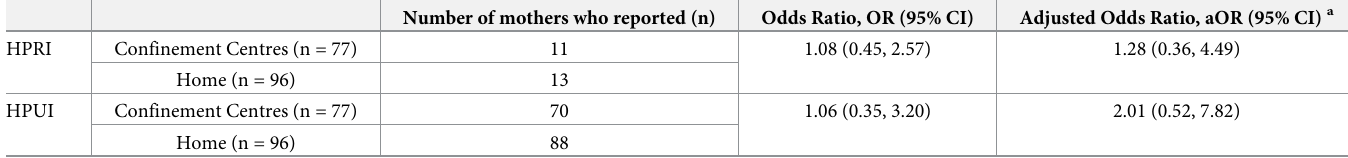
Table 5. Crude and adjusted ORs for HPRI and HPUI defined by place of